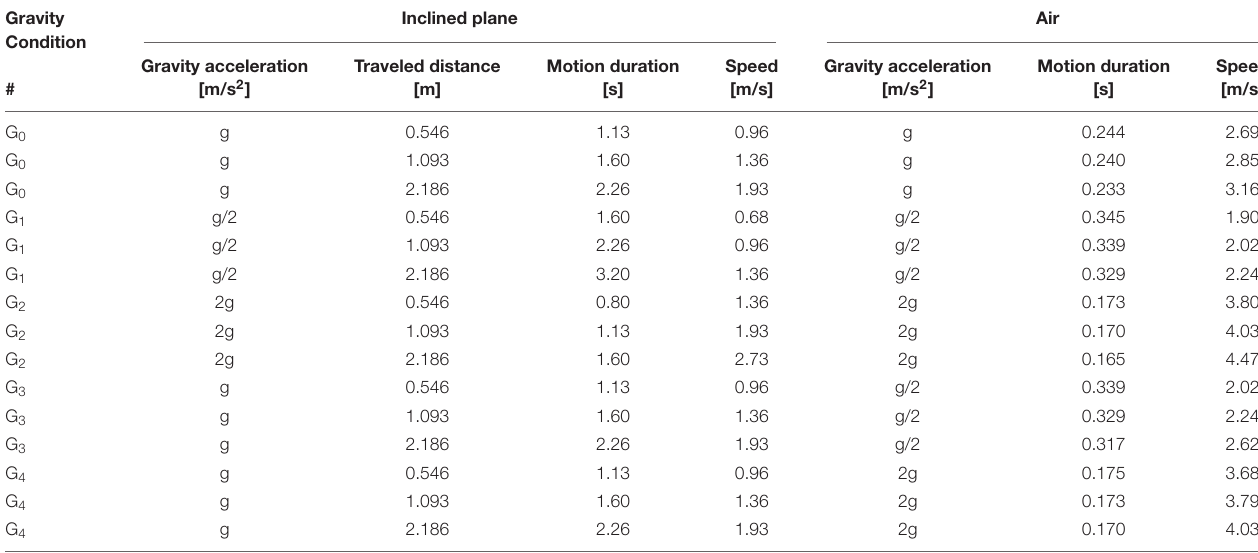
TABLE 1 | Ball motion parameters (inclined plane and air). Gravity